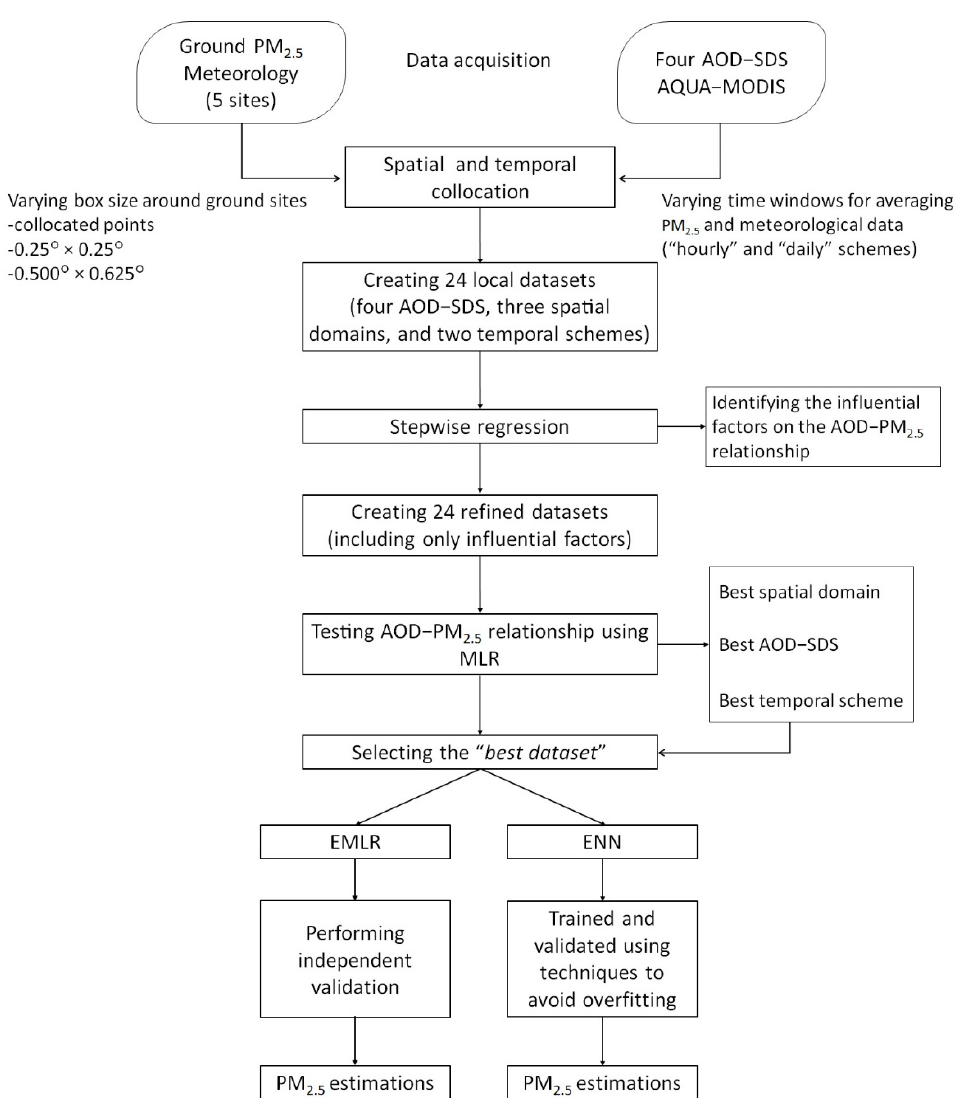
Figure 2. Methodological framework for PM 2.5 estimations in the MMA.